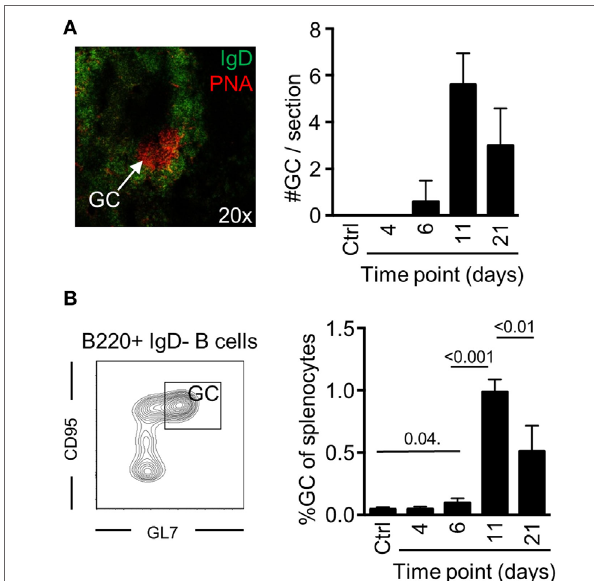
FigUre 1 | Germinal center (GC) B cell development after a single injection of mice with Env. (a) The presence of GC structures was assessed by immunofluorescence microscopy as distinct PNA + /IgD − areas (red) within follicles (PNA − /IgD + , green) in spleen sections of mice (representative image, left panel). The number of GCs in spleen sections from individual mice was enumerated at the indicated time points (right panel). (B) Flow cytometric quantification for the frequency of GC B cells (B220 + IgD − GL7 + CD95 + ) of total splenocytes is shown at the indicated time points. N (adjuvant, d4) = 4 animals; N (d6, d11, d21) = 5